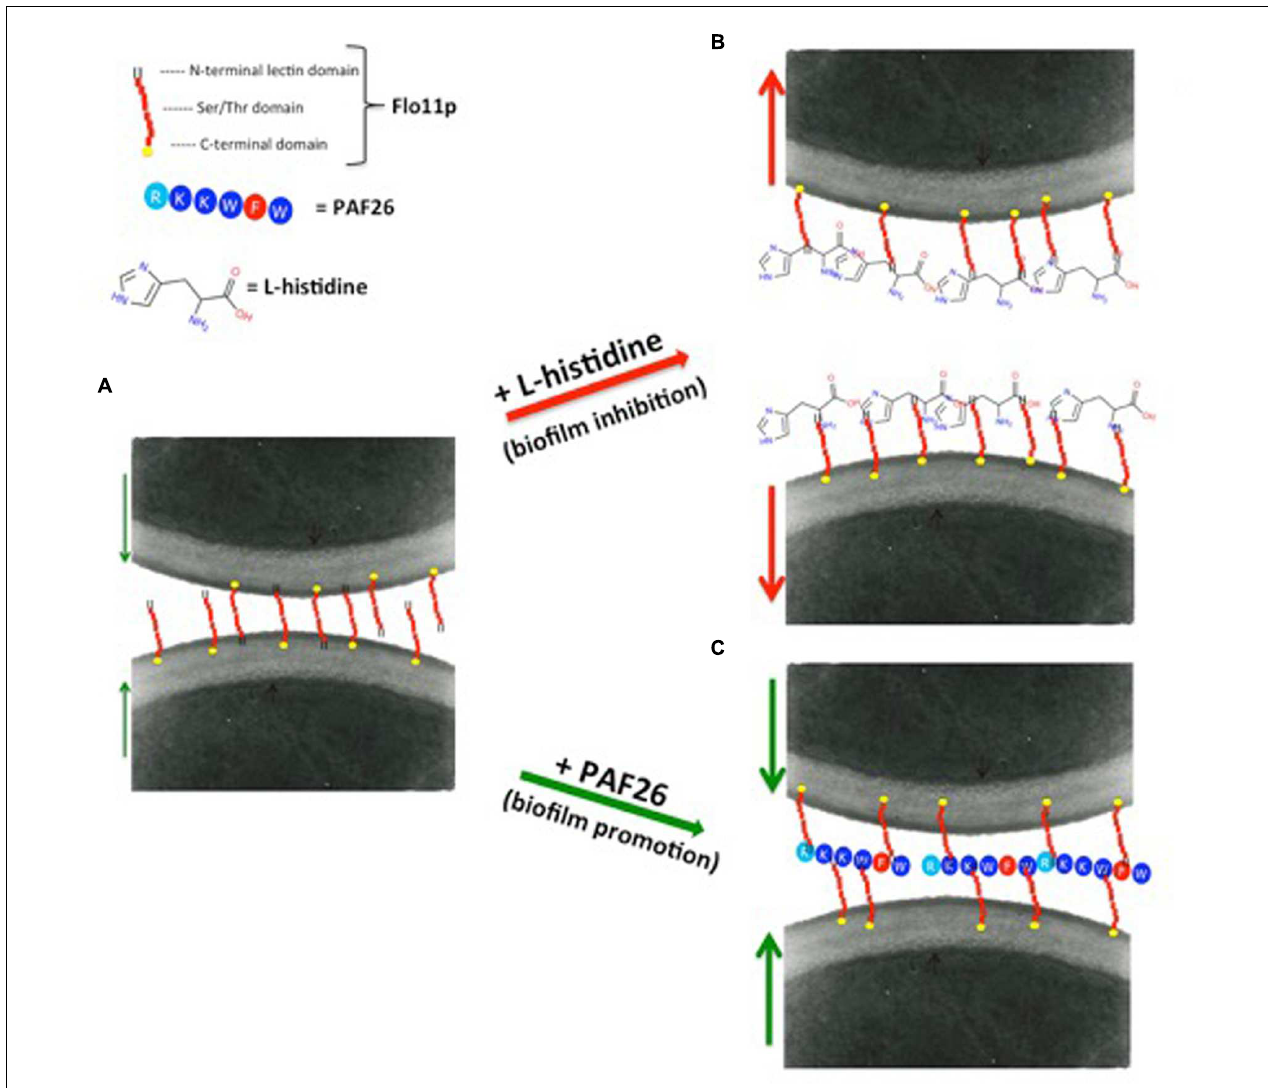
FIGURE 3 | Proposed models for promotion and inhibition of biofilm formation by flor yeast. (A) The large and highly glycosylated extracellular N-terminal domain of Flo11p confers high hydrophobicity and negative net charge to the yeast cell wall, and is responsible for cell-to-cell adhesion and biofilm formation. (B) Biofilm inhibition. Among the 20 naturally occurring amino acids, L -histidine is a cationic amino acid with a unique imidazole ring as a side chain. This feature of L -histidine might induce the loss of cell adhesion and biofilm formation of the flor strains, by providing non-specific physical interactions with the embedded cell-wall components in general, and with the highly O -mannosylated cell-wall mannoprotein Flo11p in particular. This would lead to the failure of air–liquid biofilm formation and cell adhesion. (C) Biofilm promotion. PAF26 is a highly hydrophobic and cationic peptide. Due to its properties, electrostatic and hydrophobic interactions can be established between PAF26 and Flo11p. Following this hypothesis, PAF26 would act by facilitating and bridging the Flo11p-mediated interactions between cells, and thus increasing biofilm formation. Red arrows indicate cell to cell repulsion; green arrows indicate cell to cell